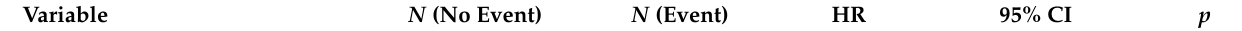
Table 3. Multivariable analysis of time-independent and time-dependent risk factors of the study group patients. Variable N (No Event) N (Event) HR 95% CI p Model 1: Accounting for mutation status (‘mutation status available’) Event-free survival (EFS) proportional hazard assumption p = 0.274